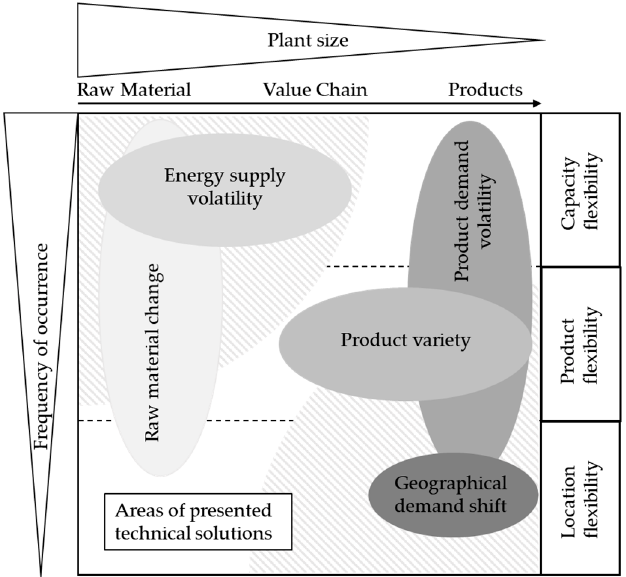
Figure 2. Classification of boundary conditions for different flexibility types with respect to plant size and frequency of occurrence along the value chain in chemical production.